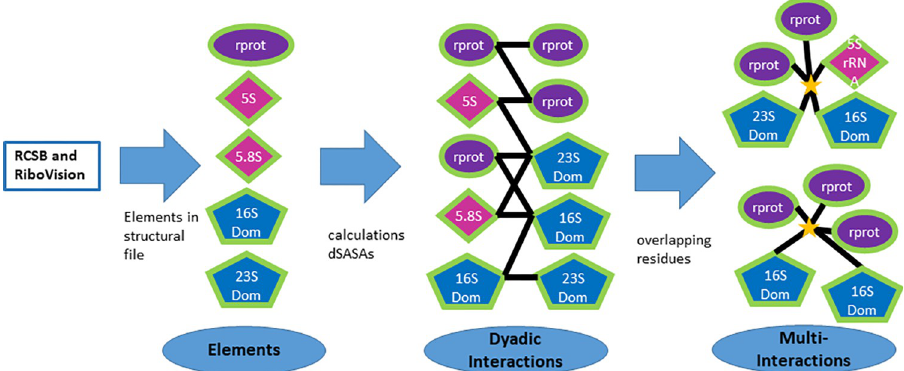
Fig 4. Schematic of the methodology used in this paper. From the information on the RCSB website concerning the pdb structural file, the elements are enumerated by their chains and the 16S and 23S are further divided into domains using the residue numbering found on the Ribovision website [18]. The dyadic interactions are then determined using pymol to calculate the difference between the solvent accessible area of each two elements separately and together. Next the residues in each dyadic interaction are compared with the residues of other dyadic interactions that contain the same elements. If any also include these residues a multiple interaction is said to exist.